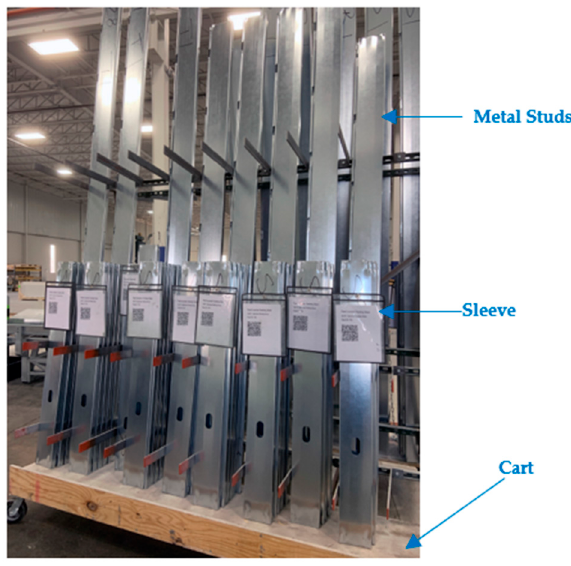
Figure 6. Example panel shop fabrication ticket.